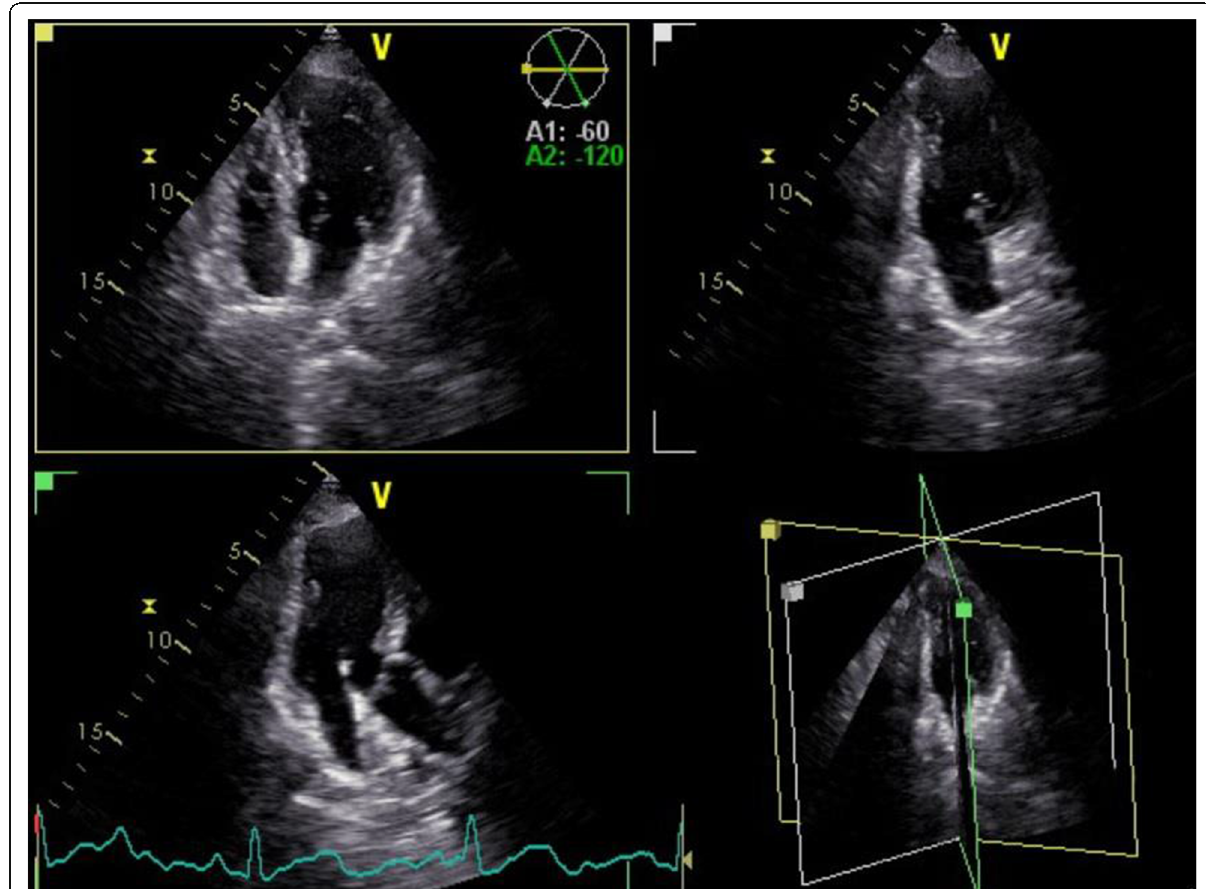
Fig. 1 Three standard views, two-, three-, and apical four-chamber, for evaluation of longitudinal